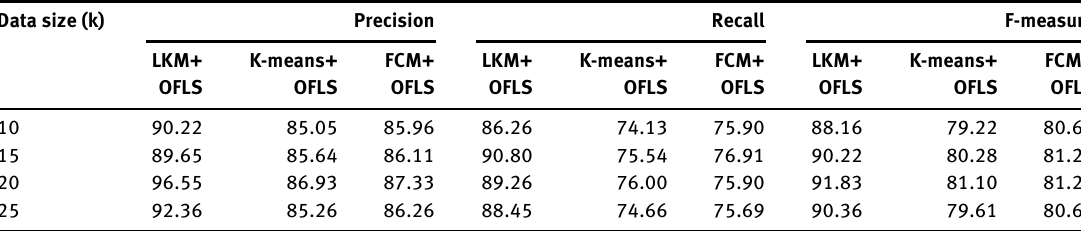
Table 7: Performance Analysis by Varying Data Size.